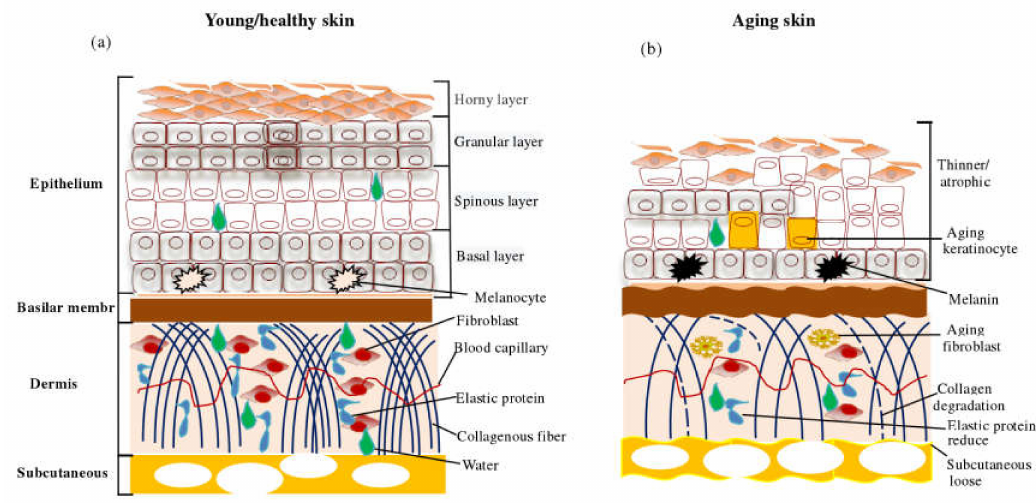
Figure 1. ( a ) Schematic diagram of skin structure, ( b ) Schematic diagram of skin structure after aging. This picture is a comparison of the changes between young skin and aging